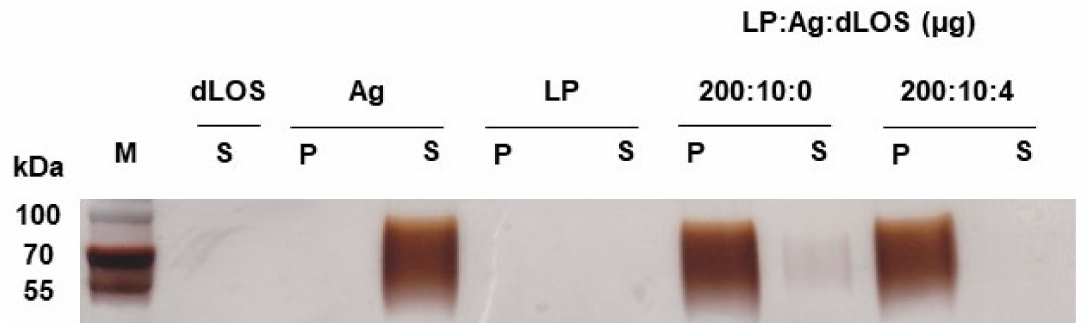
Figure 3. Adsorption of gE antigen to liposomes (LP). VZV gE antigen was mixed with liposomes alone or liposomes plus dLOS and ultracentrifuged. Pellets (P) and supernatants (S) were separated and subjected to SDS–PAGE followed by silver staining. The data shown are representative of two experiments with similar results. M, protein size